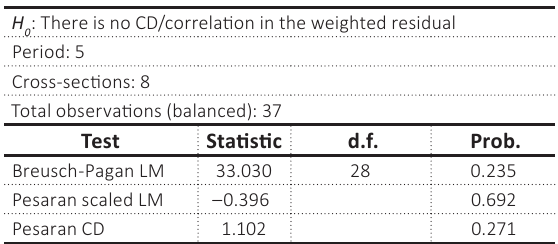
Table 6. Residual CD test